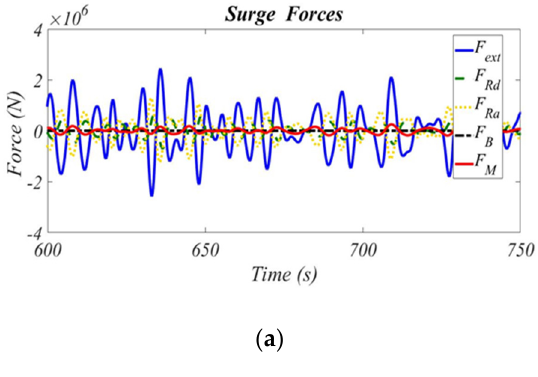
23 ( b ) Figure 19. The performance of ( a ) surge and ( b ) heave RAOs as a function of wave frequency for the MIT/NREL TLP by comparing hydrodynamic simulator with FAST. The time histories in Figure 20a,b show that the surge oscillation excites individual wave-load